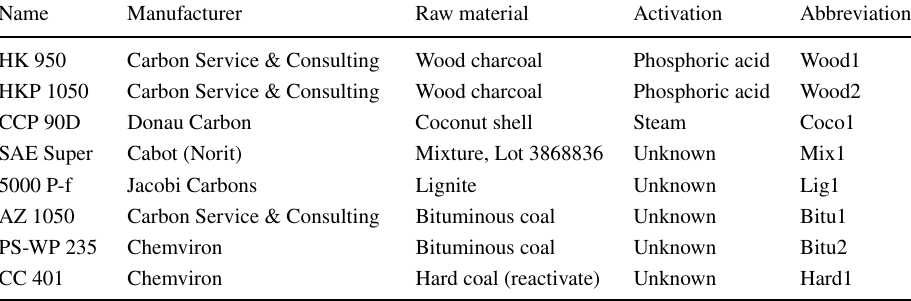
Table 1 Powdered activated carbons that were extensively investigated and the abbreviations used in the following text and figures. 5000 P-f was not analyzed using XPS and XRD due to the